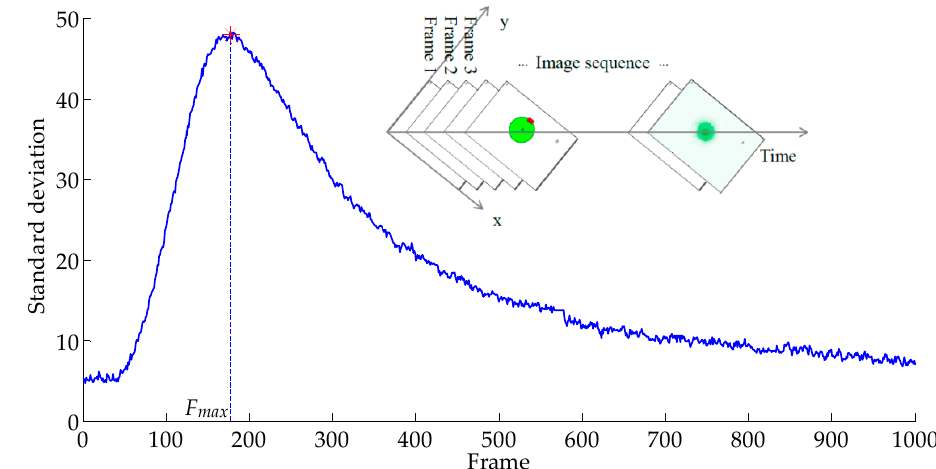
Figure 3. The history of standard deviation of the sensitive area with time.